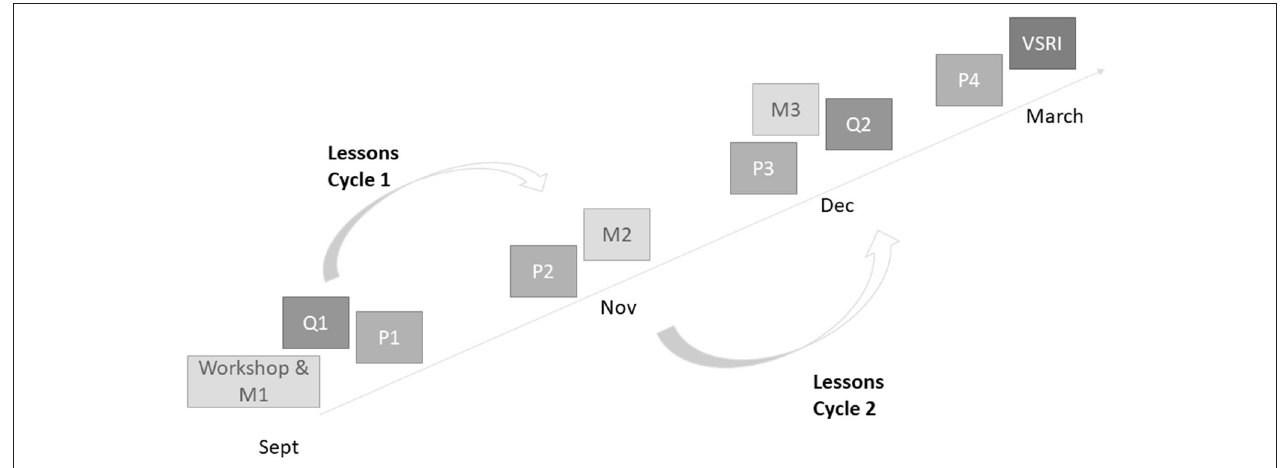
FIGURE 2 | Timeline of the action research project (M, Meeting with teachers; Q, Questionnaire; P, Performance session; VSRI, Video-stimulated recall